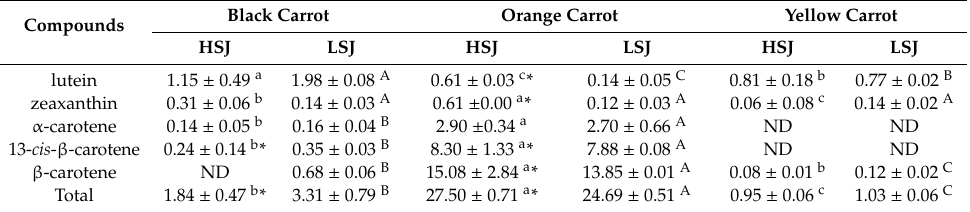
Table 1. The content (mg / 100 mL) of carotenoids in black, orange and yellow carrot juices. Black Carrot Orange Carrot Yellow Carrot Compounds HSJ